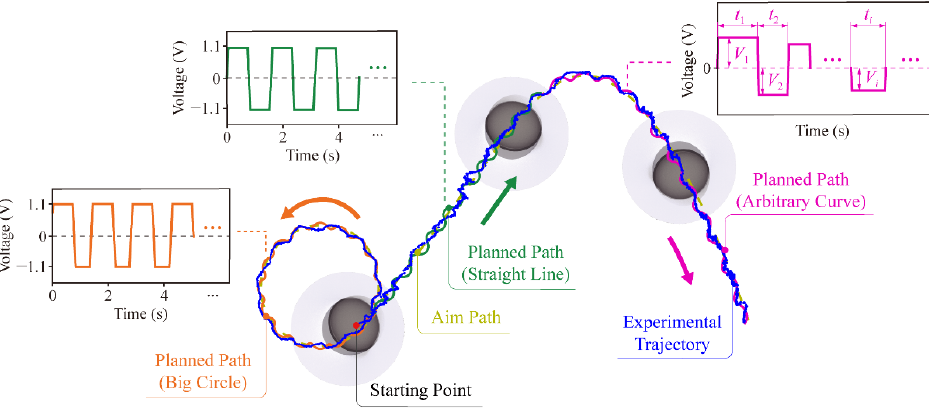
Figure 6. The path of the robot while fitting a large circle, a straight line, and an arbitrary curve, respectively. (1) At first, we split the aim path (light green dashed line) into arcs of different diameters and lengths that the robot can